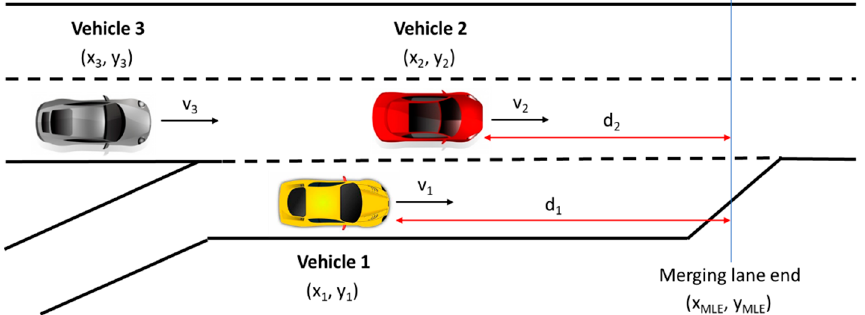
Figure 1. Vehicles in the merging lane (Vehicle 1) and in the main road (Vehicles 2 and 3), and the variables involved in the